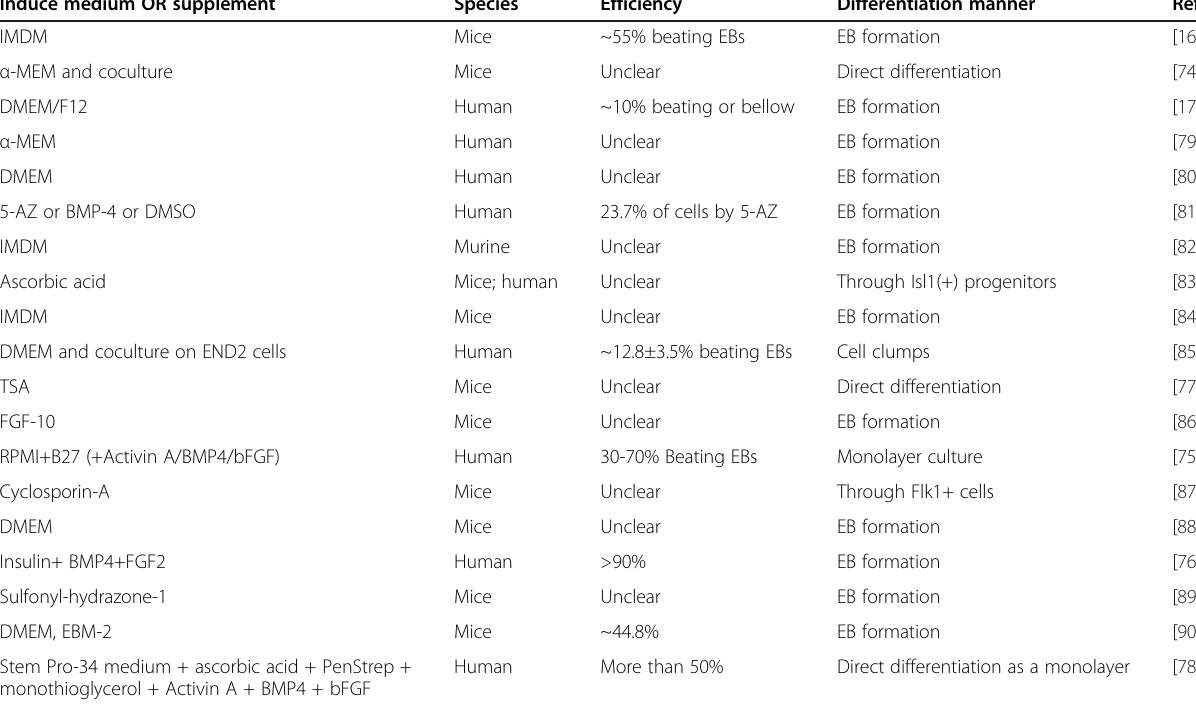
Table 2 Cardiac differentiation from iPSCs Induce medium OR